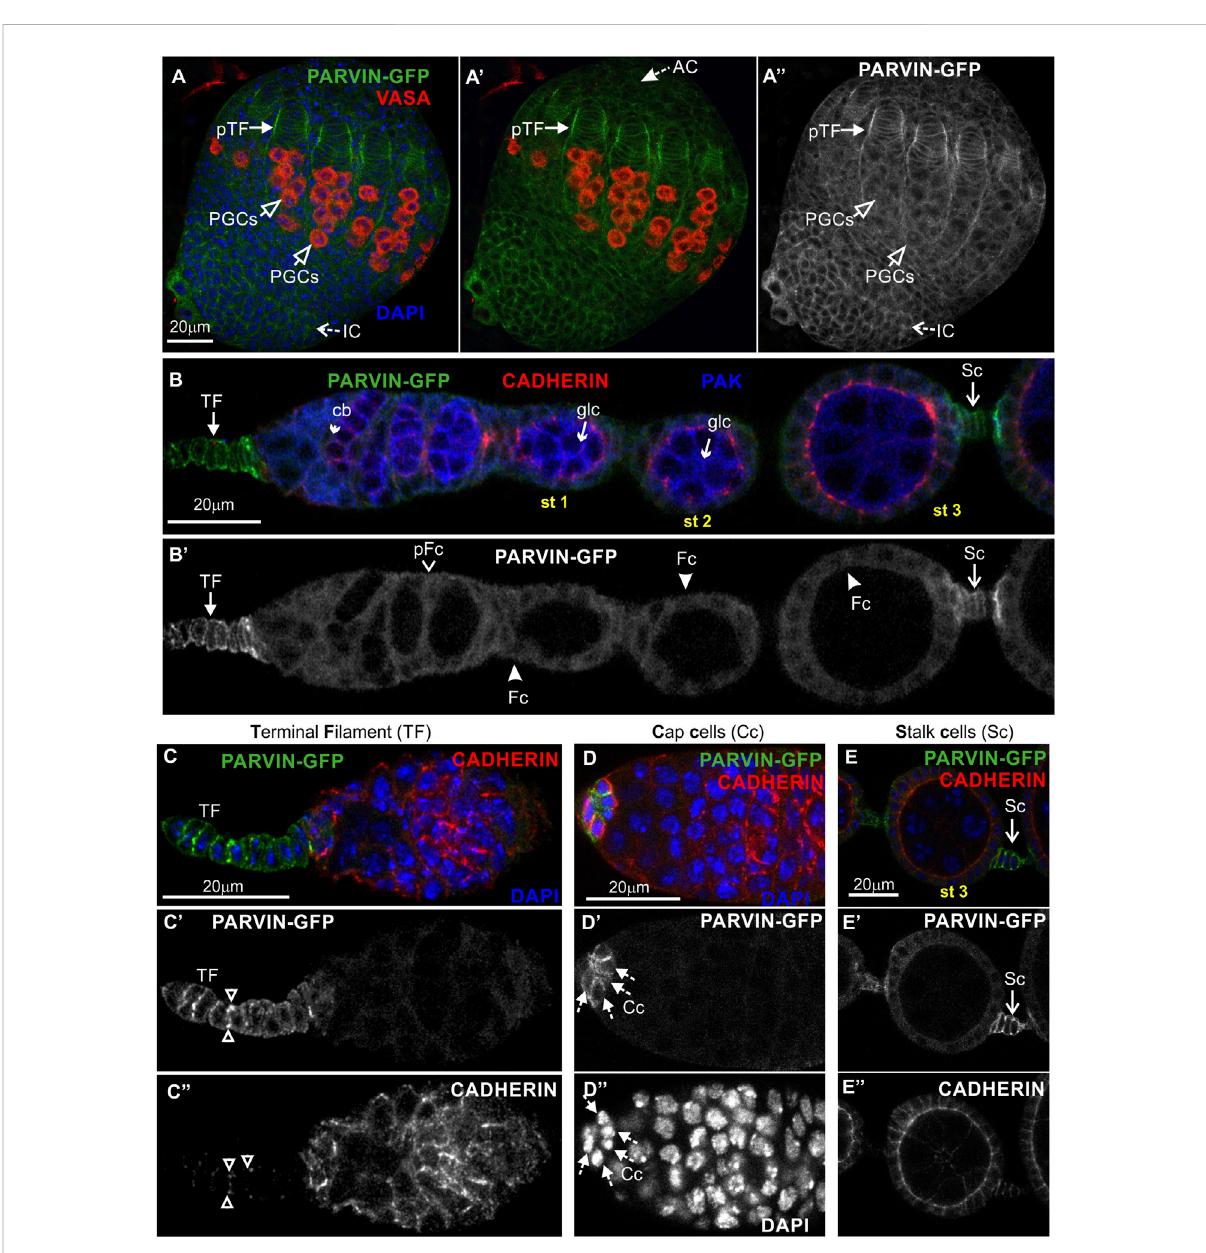
FIGURE 3 Parvin-GFP expression in the developing ovary and the adult egg chamber. Confocal micrographs of a pupal ovary and adult egg chambers, all expressing GFP-tagged Parvin to reveal the endogenous spatiotemporal protein expression and subcellular distribution. (A-A") Early pupal (2 – 4h APF) ovary expressing Parvin-GFP. The protein is enriched in the lateral sites of terminal fi lament cell precursors and in the periphery of interstitial cells, apical cells and primordial germ cells. PGCs were marked with antibodies against Vasa. (B – E") Parvin-GFP expression in the early previtellogenic egg chambers of an adult ovariole shows (B-B ′ ) low level of protein expression in pre-follicle and follicle cells, but signi fi cant enrichment in the periphery of (C-C") terminal fi lament cells, (D-D") cap cells in the germarium region and (E-E") in the interfollicular stalk cells. Co- stainingagainstCadherinandPAKproteinsshowsforParvin-GFPaclearlydistinctpatternofexpressionandlocalizationfromtheepithelialandgerm celllineages.AC,apicalcells;pTF,precursorofterminal fi lament;TF,terminal fi lament;PGCs,primordialgermcells;IC,interstitialcells;Cc,capcells; cb, cystoblast; glc, germline cyst; pFC, pre-follicle cell; Fc, follicle cells; Sc, stalk cells. Scale bars: 20 μ m in all